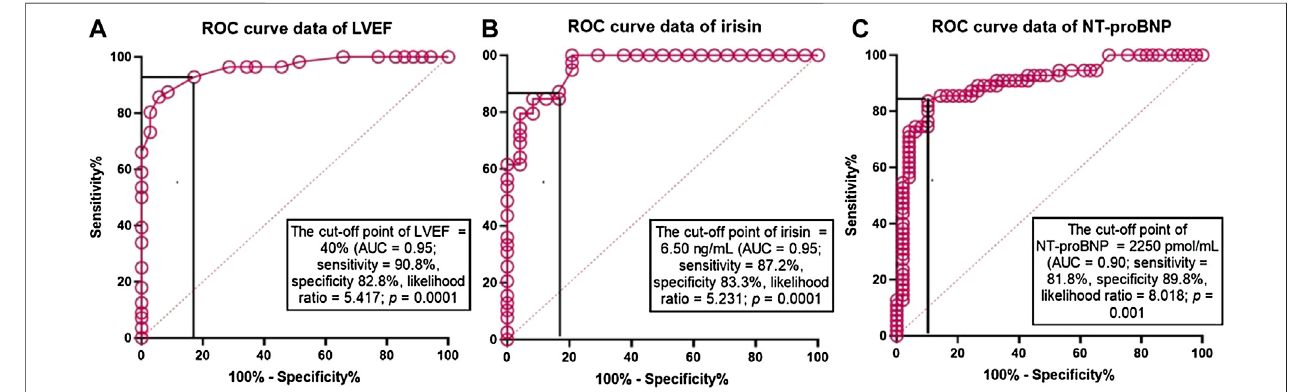
FIGURE 2 | The predictive reliability of LVEF, seru, levels of irisin and NT-proBNP for cumulative CV outcomes: The results of ROC curve analysis. Receiver Operating Characteristic Curves illustrate reliability of predictive models constructed from LVEF, serum levels of irisin and NT-proBNP for cumulative CV outcomes. Abbreviations: AUC, area under curve; NT-proBNP, N-terminal fragment of pro-brain natriuretic peptide.